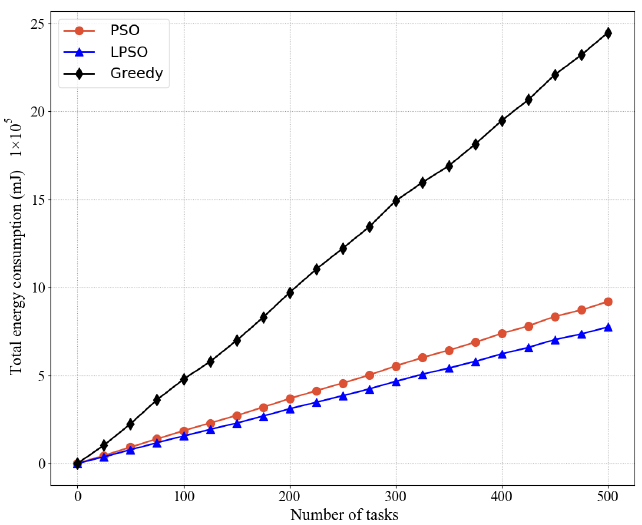
Figure 4. Comparing the total energy consumption of different algorithms in the same case where the weight of LPSO is V = 50.